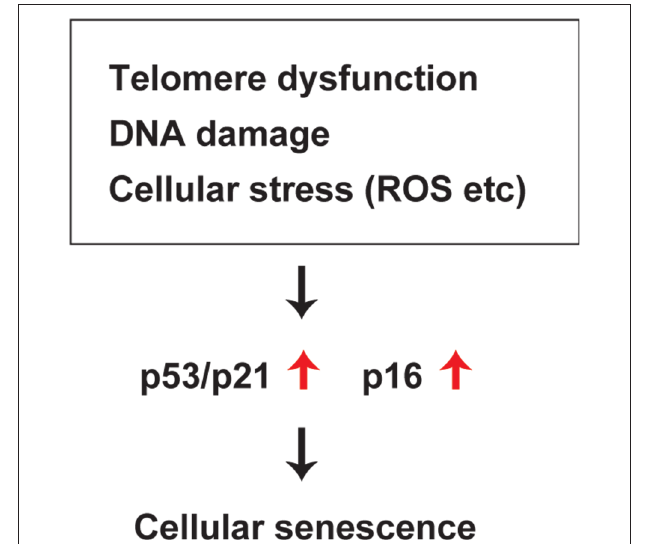
FiguRe 1 | Common pathways of cellular senescence. Telomere dysfunction, DNA damage, cellular stress (ROS etc) up-regutate p53/p21, p16 signal and induces cellular